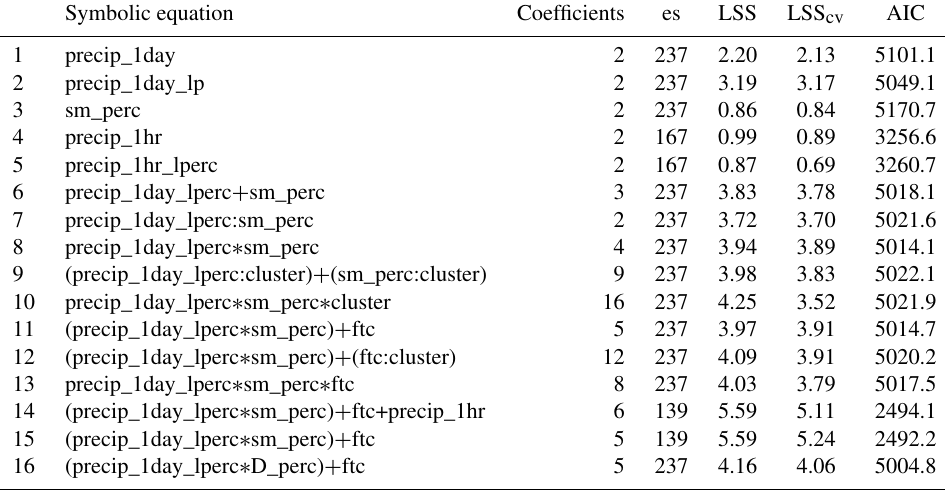
Table 1. Symbolic formulae for a list of logistic regression models tested in this study and main characteristics associated with these models. The characteristics include the number of coefficients that needed to be determined, the number of event sites (es) that were used for fitting, the logarithmic skill score (LSS), the logarithmic skill score determined by cross validation (LSS cv ) and the Akaike information criterion (AIC). See text for explanation of symbolic equation